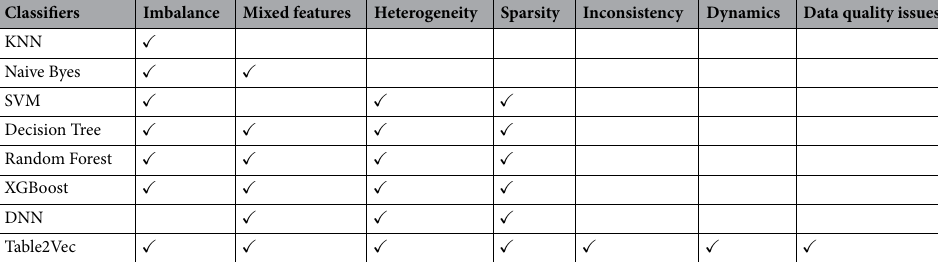
Table 1. Fitness of self-contained classifiers to address characteristics and issues in enterprise data. Typical classifiers only focus on classification, requiring heavy and duplicated commitments by each analyst to address similar data quality issues. Table2Vec instead addresses both data quality issues and representation learning in one go, enabling end-to-end and automated enterprise data